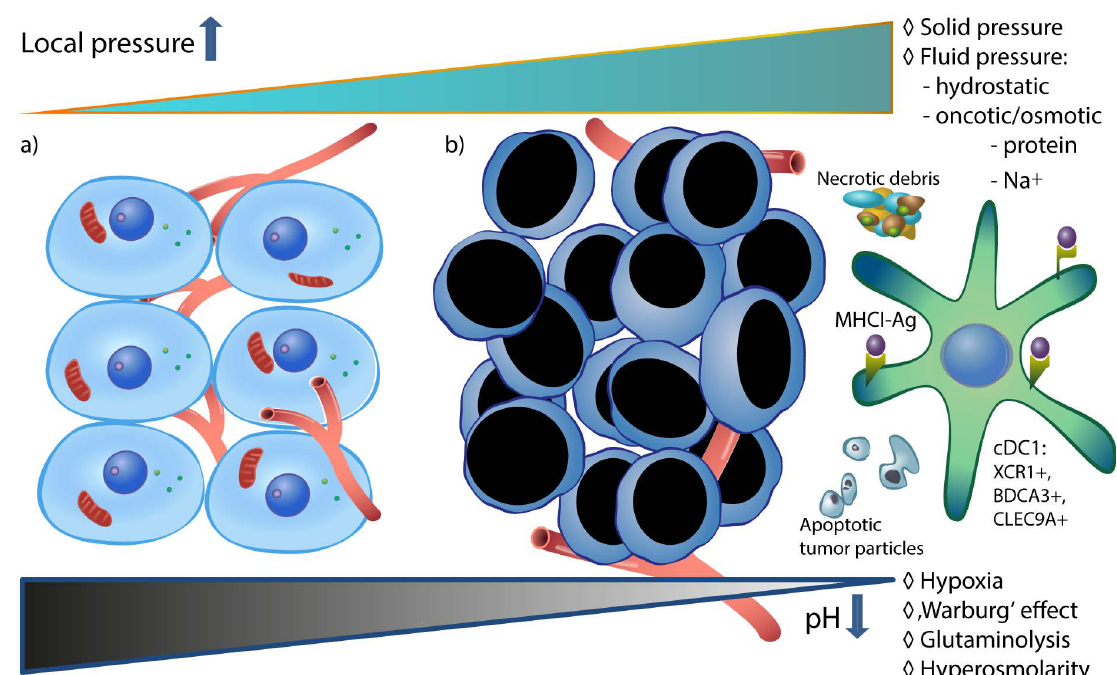
Figure 1. Typical microenvironment of tumor-associated cDC1 is acidic and hypertonic. In comparison to physiologic conditions ( a ), malignant neoplastic tissue ( b ) is characterized by lactate-induced decrease of pH value via hypoxia, aerobic glycolysis and glutaminolysis. On the other hand, increased (fluid and solid) pressure of tumor interstitium depends on biophysical characteristics of tumor mass, tumor cell death rate, abnormal blood supply but also nutritive aspects, like high-salt diet. Increased extracellular Na + may further enhance lactate accumulation via supporting aerobic